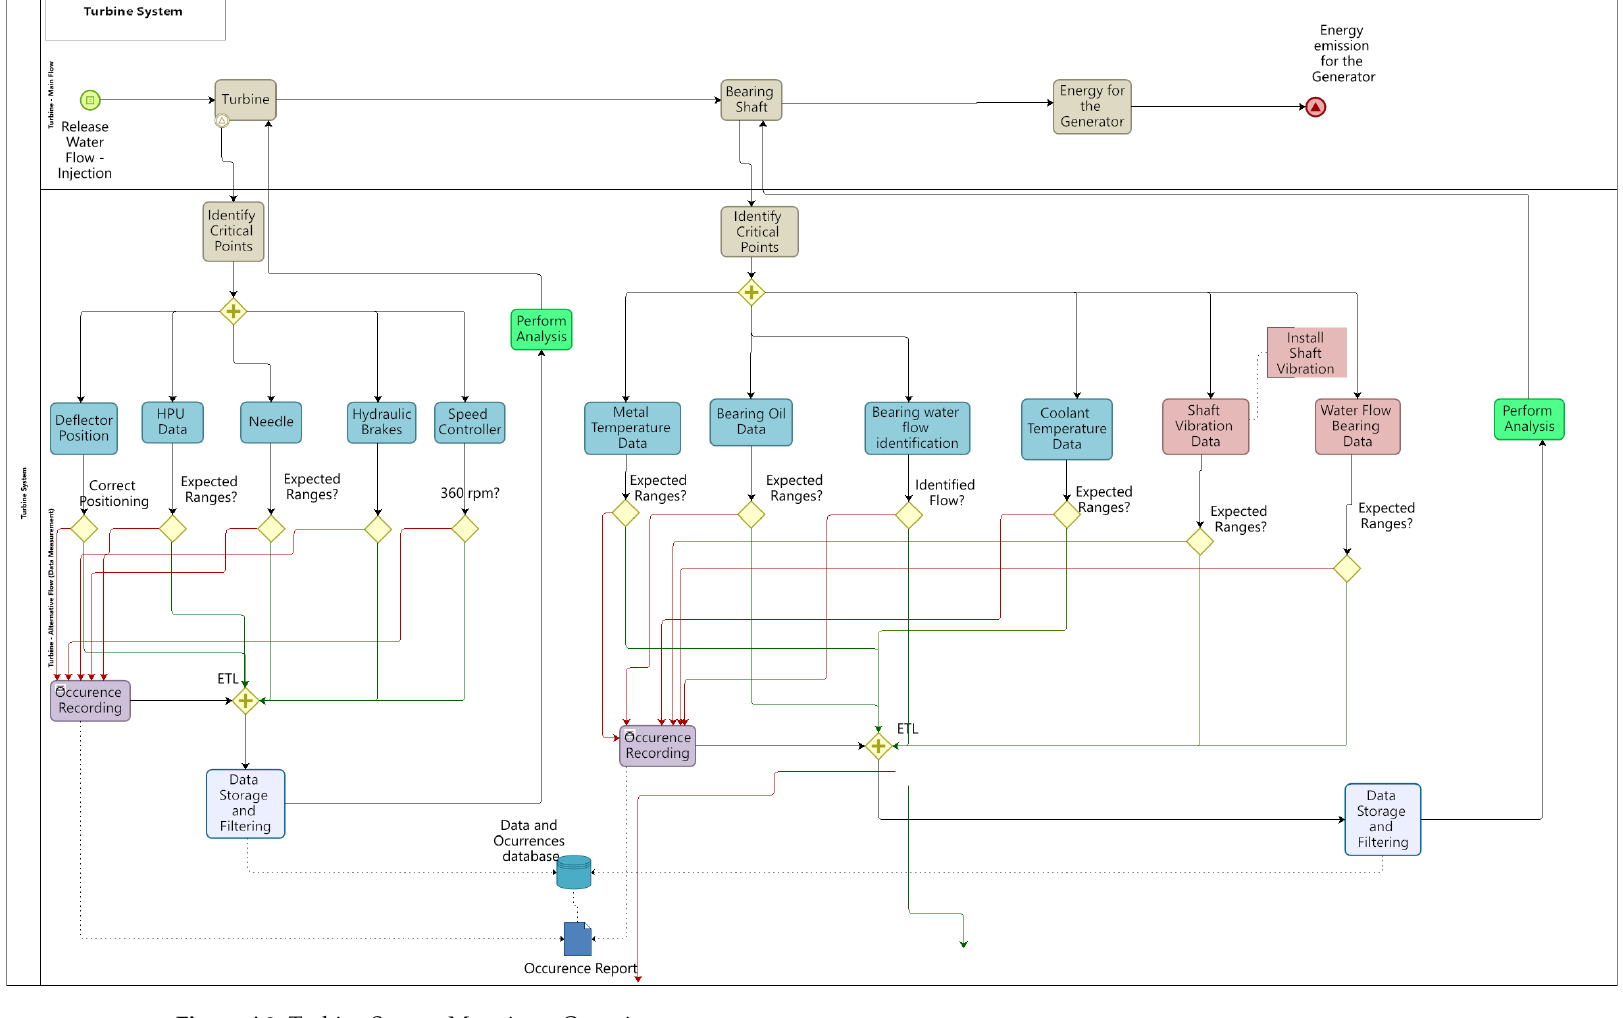
Figure A2. Turbine System